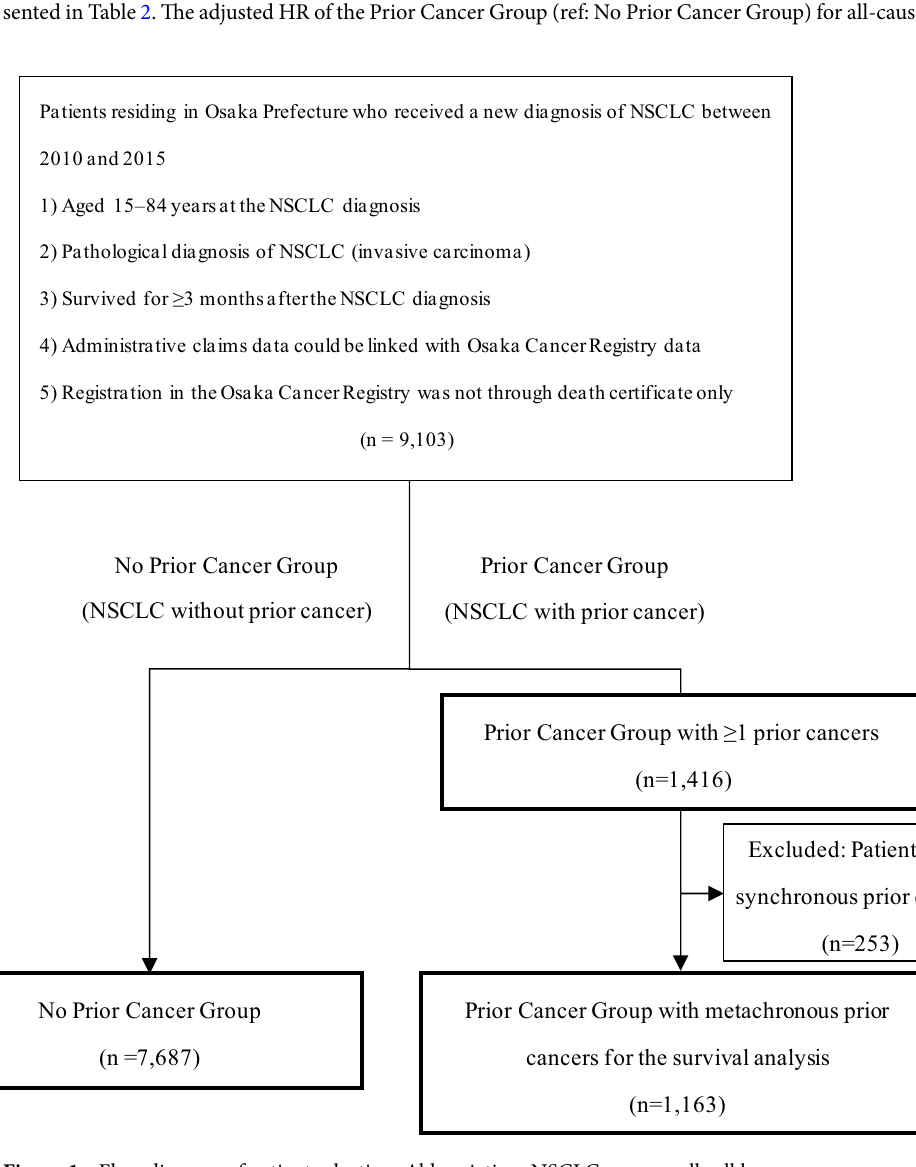
Figure 1. Flow diagram of patient selection. Abbreviation: NSCLC, non-small cell lung